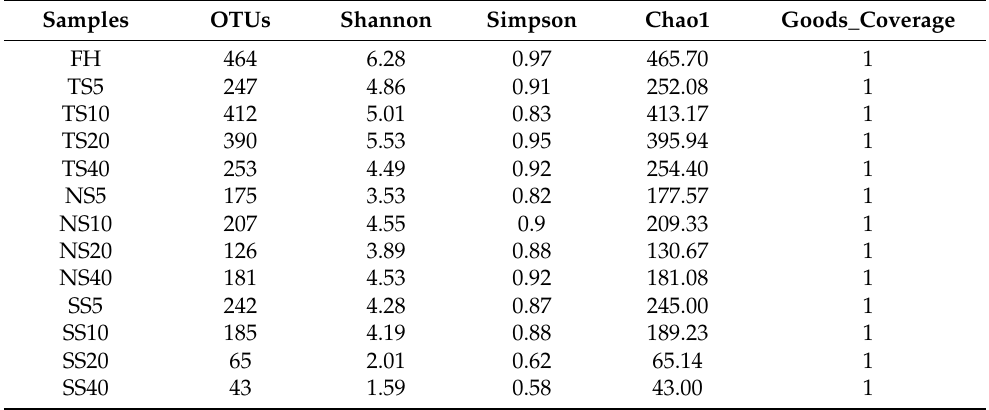
Table A1. Biodiversity index of microorganisms in the salted herring under different processing